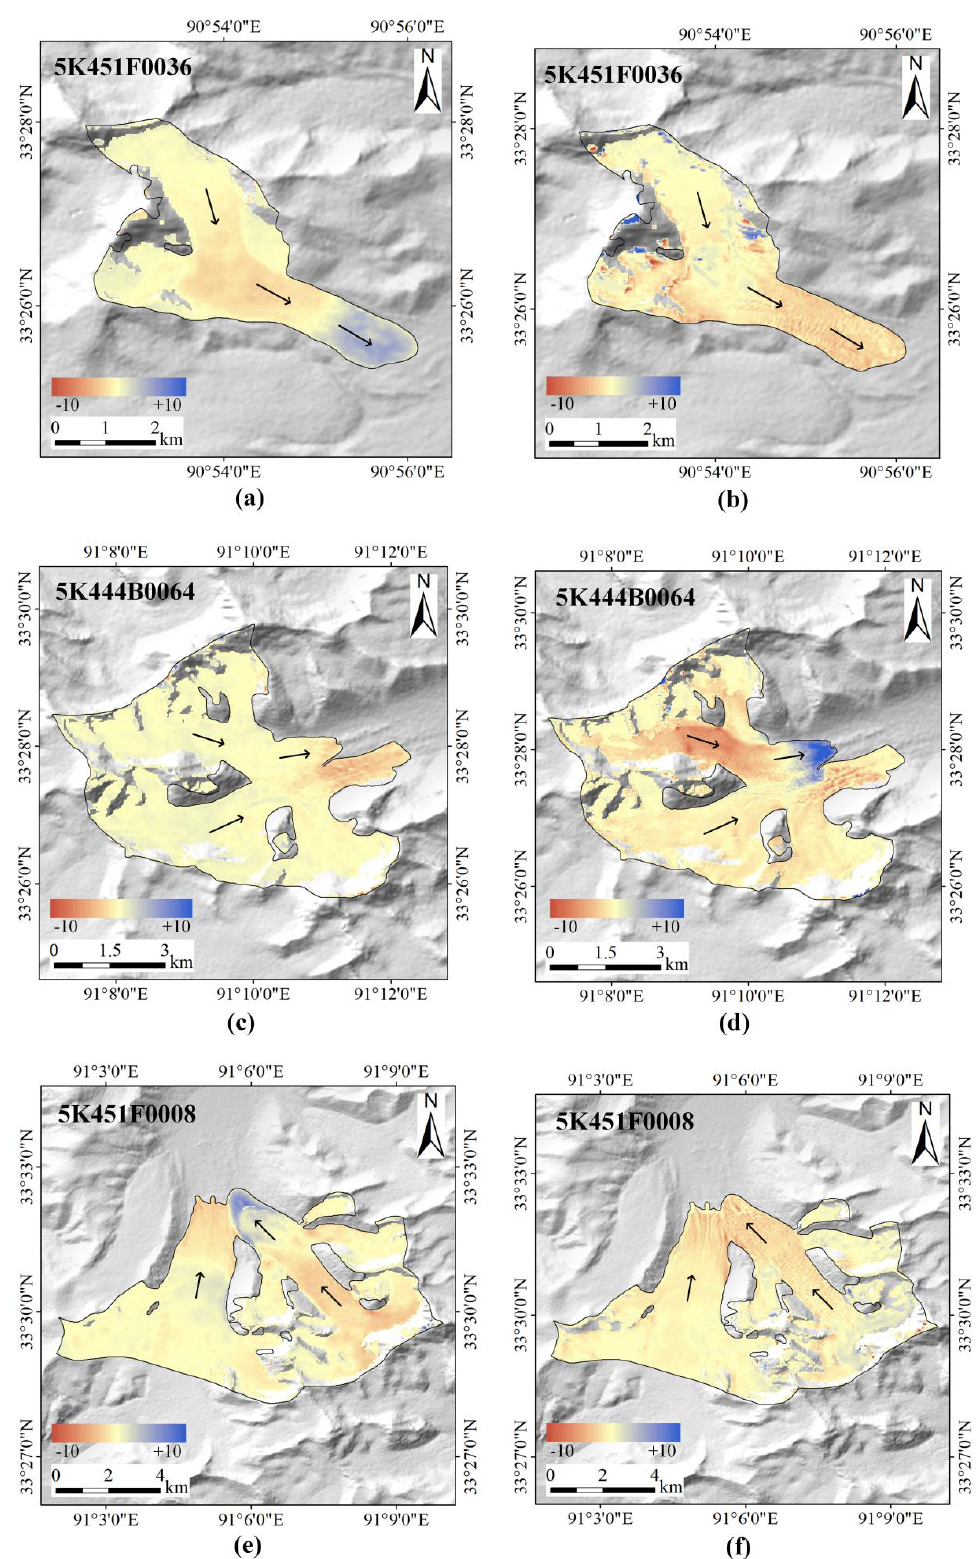
Figure 7. Same as Figure 6 but for three surge-type glaciers of 5K451F0036, 5K444B0064, and 5K451F0008. ( a ), ( c ) and ( e ) are the observations in the period 2000 − 2012; ( b ), ( d ) and ( f ) are the observations in the period 2012 − 2018. Black arrows indicate the directions of glacier surface